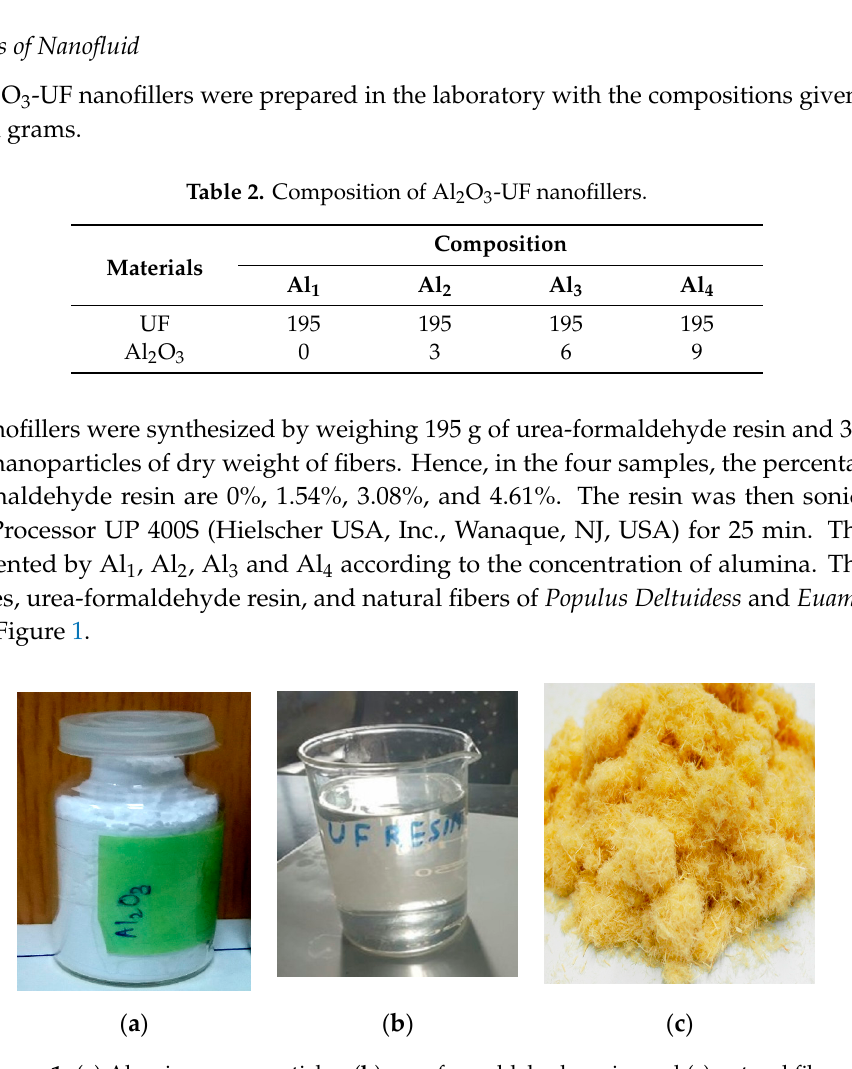
Figure 1. ( a ) Alumina nano-particles, ( b ) urea formaldehyde resin, and ( c ) natural fibers.